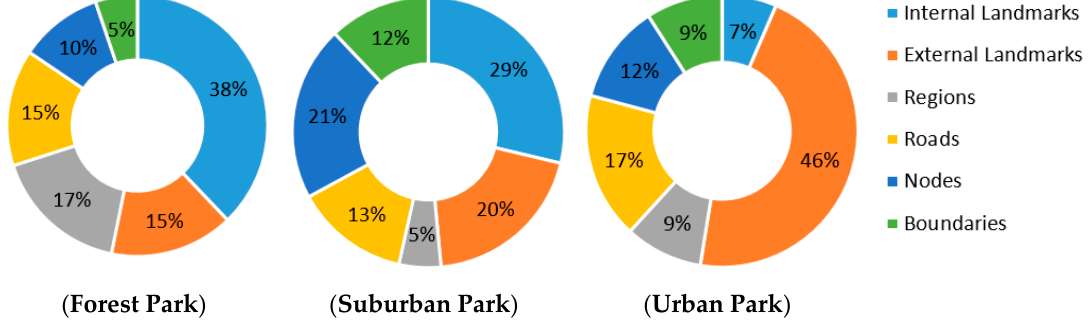
Figure 4. Frequency distribution of familiar units in the cognition maps of different kinds of urban Figure4. Frequencydistributionoffamiliarunitsinthecognitionmapsofdi ff erentkindsofurbanforests. forests.